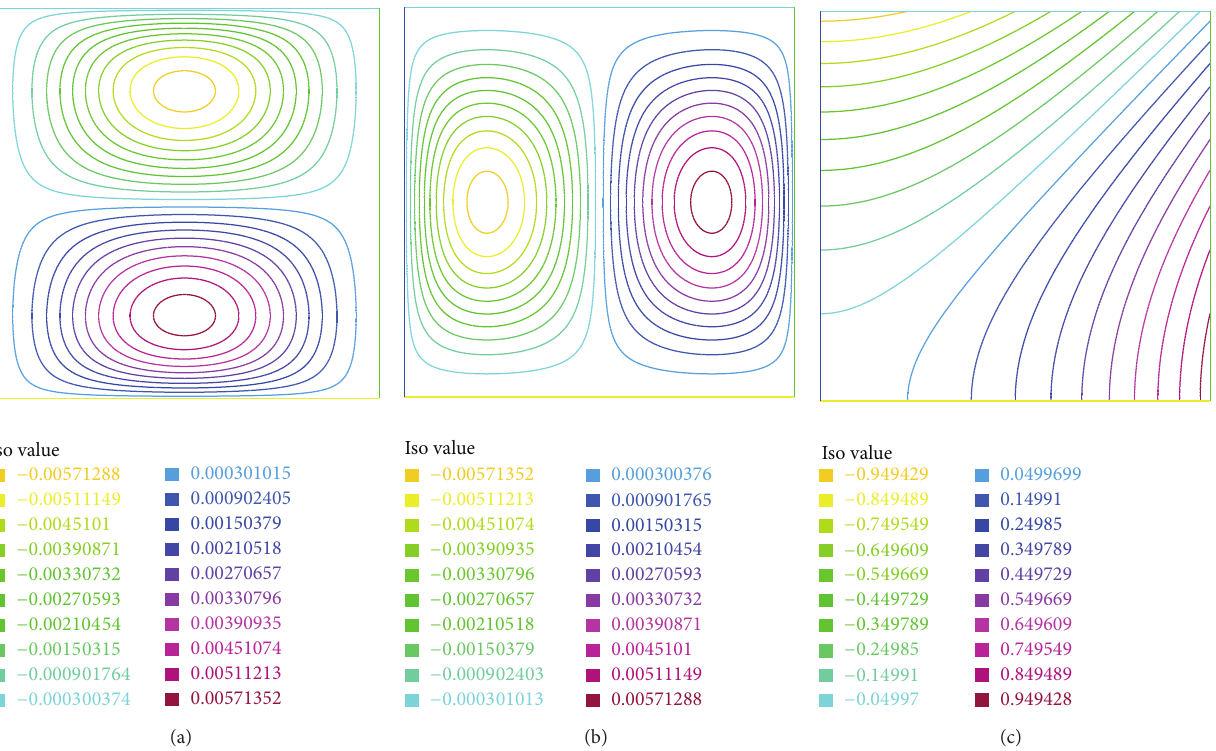
Figure 3: Contour plots of numerical solution by two-level Newton iteration method. From left to right: two components of velocity and pressure.